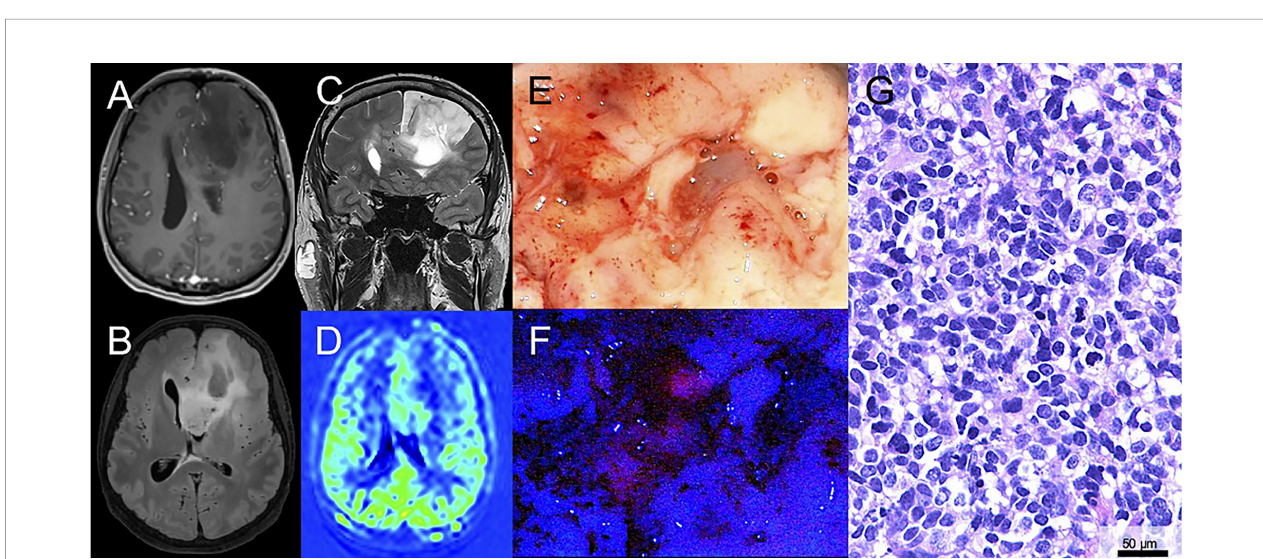
FIGURE 1 | Illustrative case of a patient with a suspected low-grade glioma (LGG) with surgical resection after 5-ALA administration. (A) Magnetic resonance imaging of a 43-year-old male patient reveals a suspected LGG in the left frontal lobe. On T1-weighted sequences no signi fi cant contrast-media enhancement is observed. (B, C) On fl uid-attenuated inversion recovery (FLAIR) and T2-weighted sequences the lesion is hyperintense. (D) Perfusion imaging shows no hyperperfusion. (E) During surgical tumor resection, conventional white-light microscopy was used. (F) Additionally, the microscope was repeatedly switched to violet-blue excitation light and an intratumoral area of visible fl uorescence was detected. (G) Histopathological analysis revealed an anaplastic astrocytoma WHO grade III (IDH mutated).